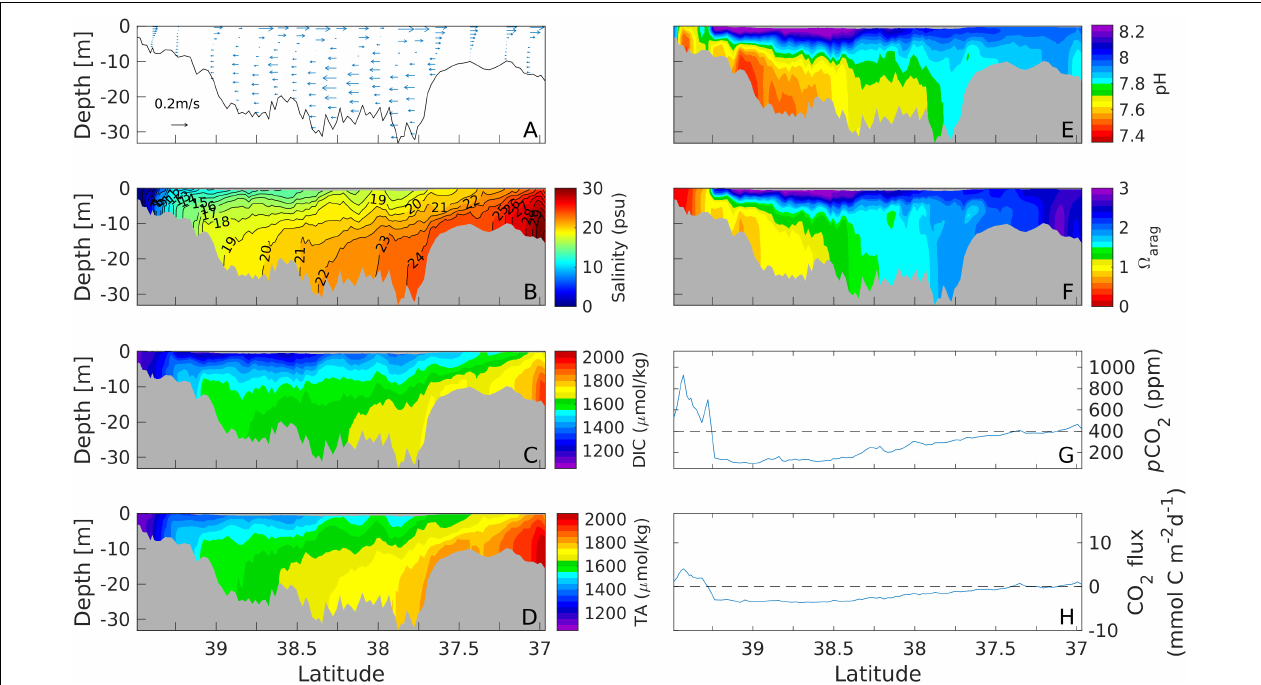
FIGURE 3 | Along channel distributions of subtidal current (A) , salinity (B) , DIC (C) , TA (D) , pH (E) , (cid:127) arag (F) , surface p CO 2 (G) , and air-sea CO 2 flux (H) during a weak wind period on 2–5 October, 2013. The along-channel section is marked by the black line in Figure 1A .